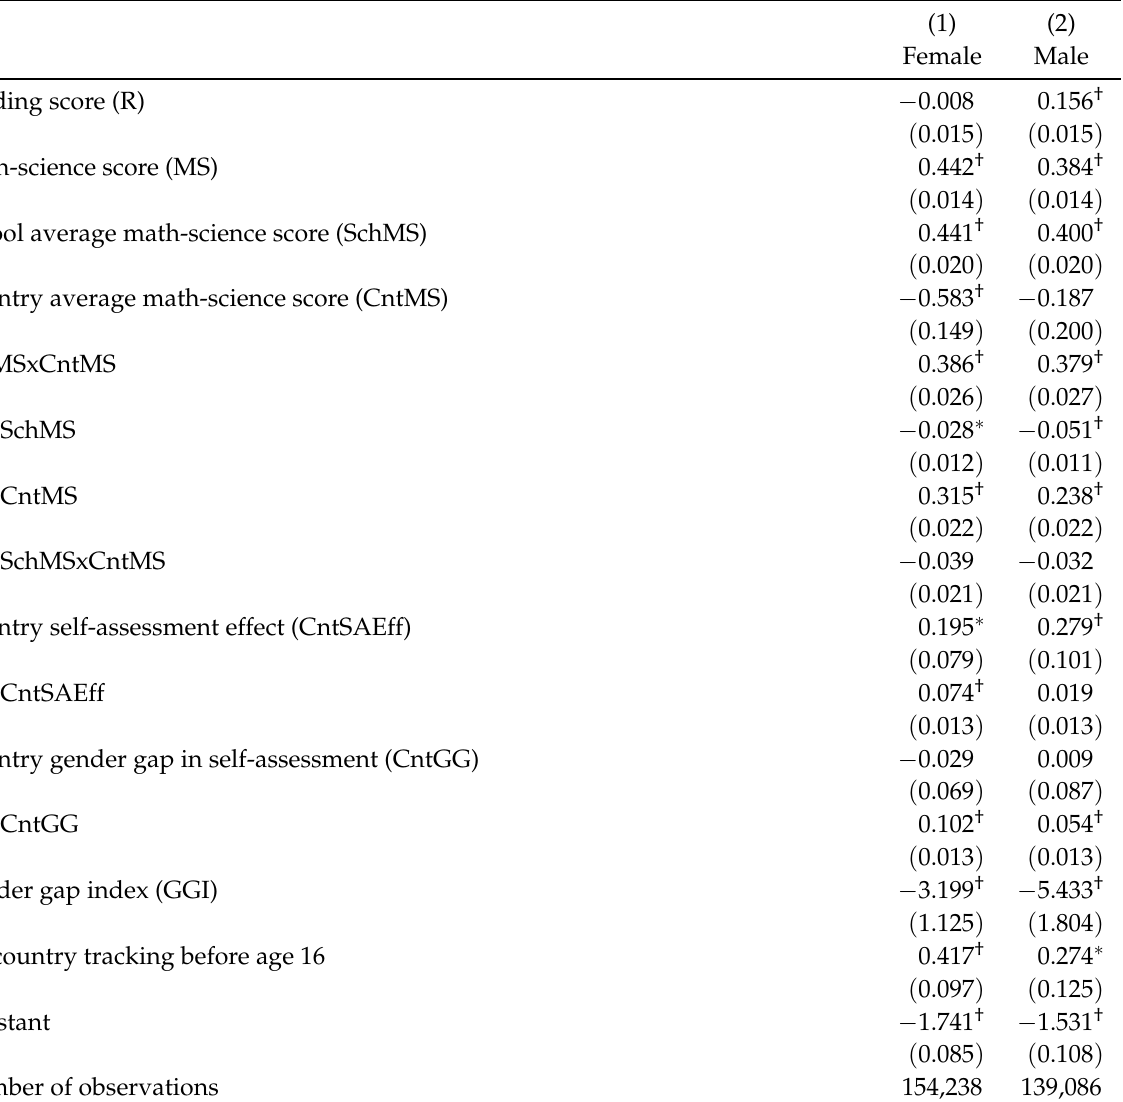
Table 5: Models for STEM Orientation Including Interaction Effects with the Gender Gap in the